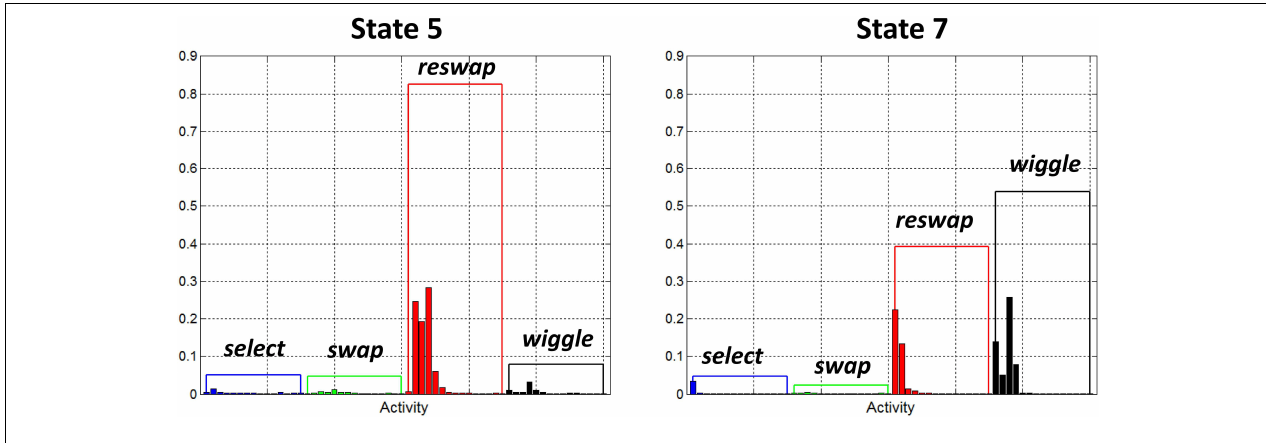
FIGURE 7 | Observation probability distributions for states 5 and 7. Each of these states has been identified as a “sequential search” state. They represent behavior of participants who haven’t yet discovered how to score points in the game, as demonstrated by the low probabilities